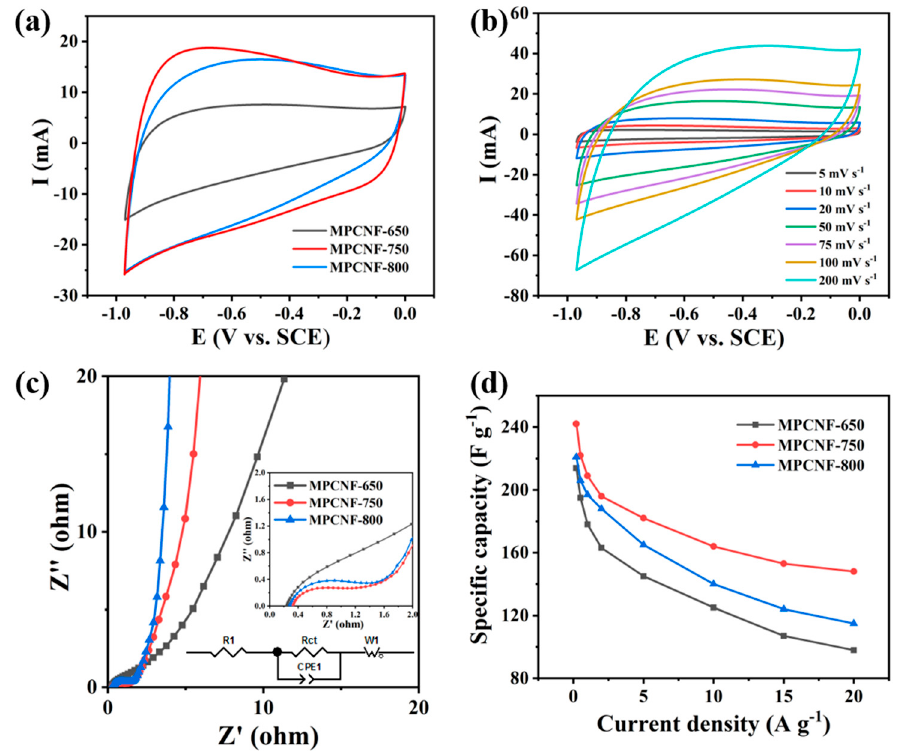
Figure 4. ( a ) CV curves of MPCNF − 650, MPCNF − 750 and MPCNF − 800 materials at the scanning speed of 50 mV s − 1 . ( b ) CV curve of MPCNF − 750 sample at different scanning speeds. ( c ) EIS spectrum of MPCNF − 650, MPCNF − 750 and MPCNF − 800. ( d ) Comparison of specific volume values of MPCNF − 650, MPCNF − 750 and MPCNF − 800.